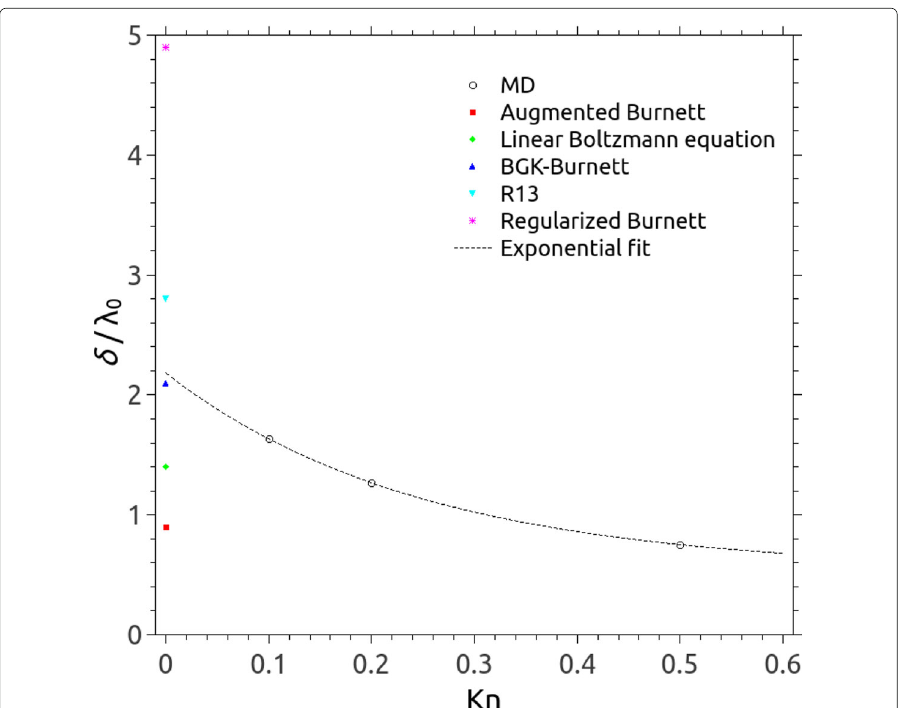
Fig. 7 Thickness of the Knudsen layer predicted by different approaches: MD (open circles), Augmented Burnett (red filled squares) [49], Linear Boltzmann equation (green filled diamonds) [20], BGK-Burnett (blue filled triangles) [50], R13 (filled downtriangles) [51], and Regularised Burnett (pink stars) [52]. The dashed line refers to an exponential fit for our MD measurement. Note that the thickness of the Knudsen layer is normalised by the nominal MFP λ 0 and is related to the Kramers’ problem, i.e. Kn → 0 presented in the